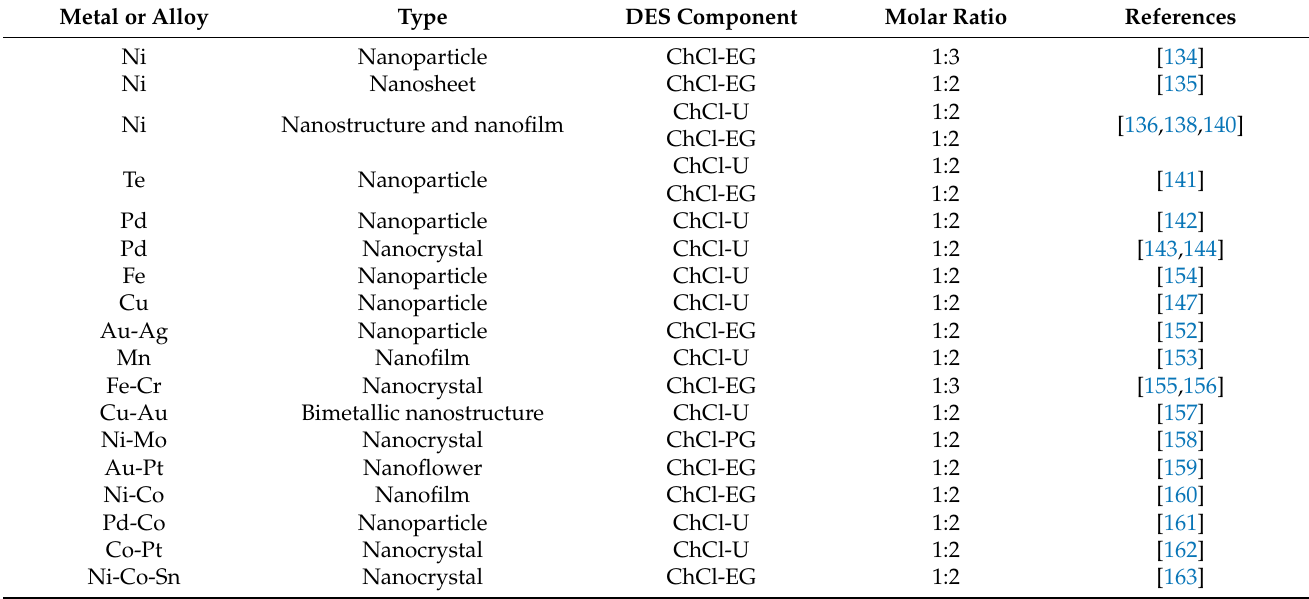
Table 1. Electrodeposition of nanostructures of metals and alloys with DESs-based choline